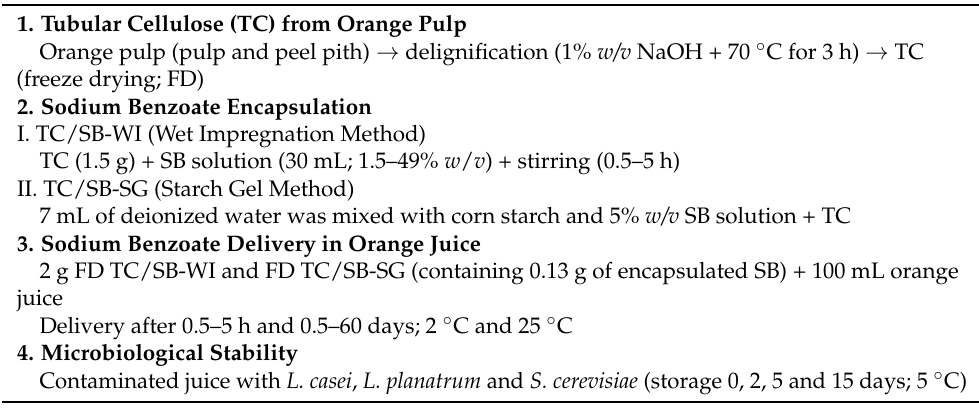
Table 1. Experimental